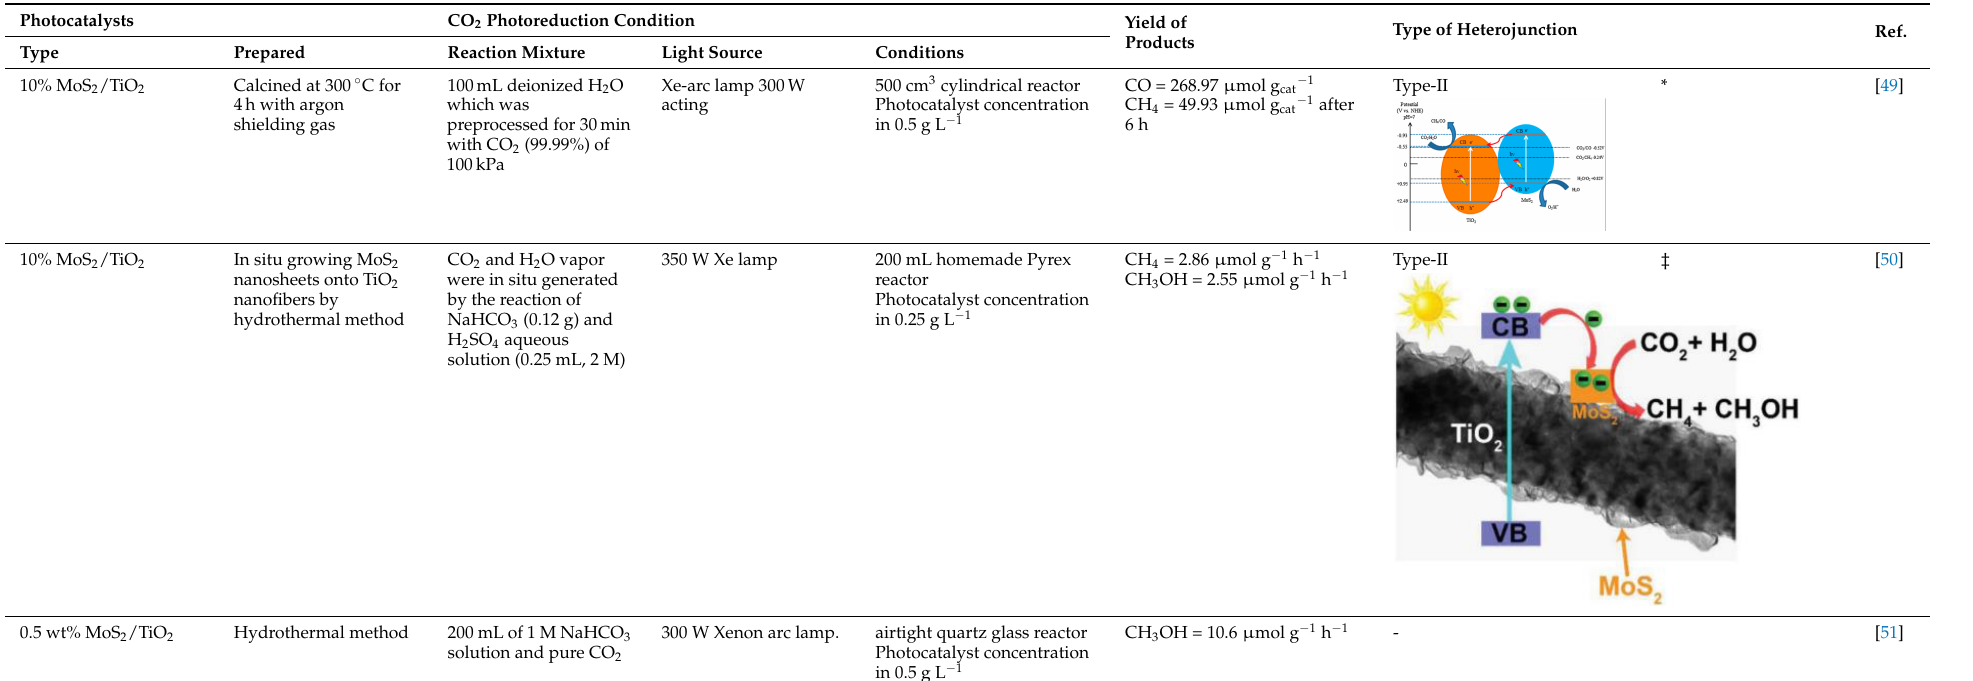
Table 6. CO 2 photoreduction using MoS 2 /TiO 2 heterojunction